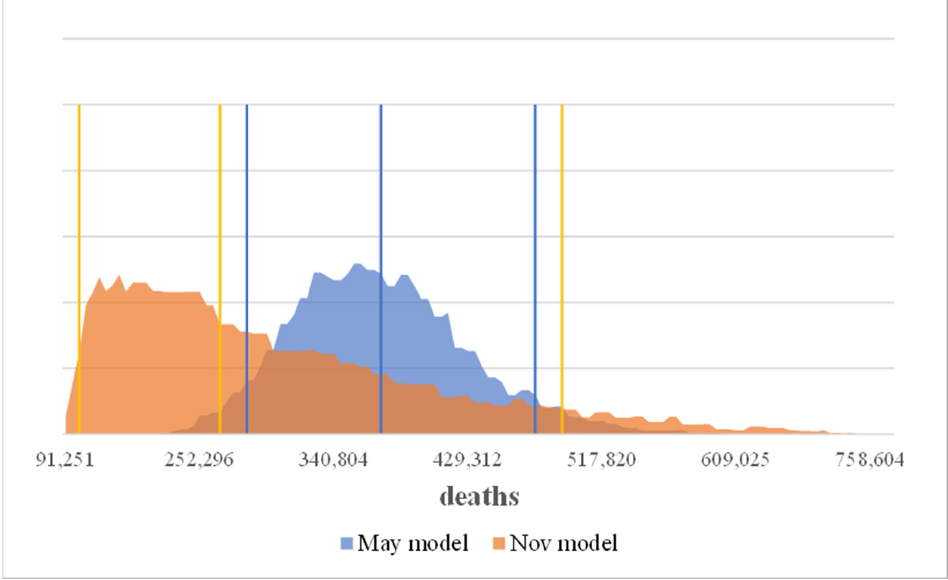
Figure 4. Number of deaths without measures at the end of the analyzed period.